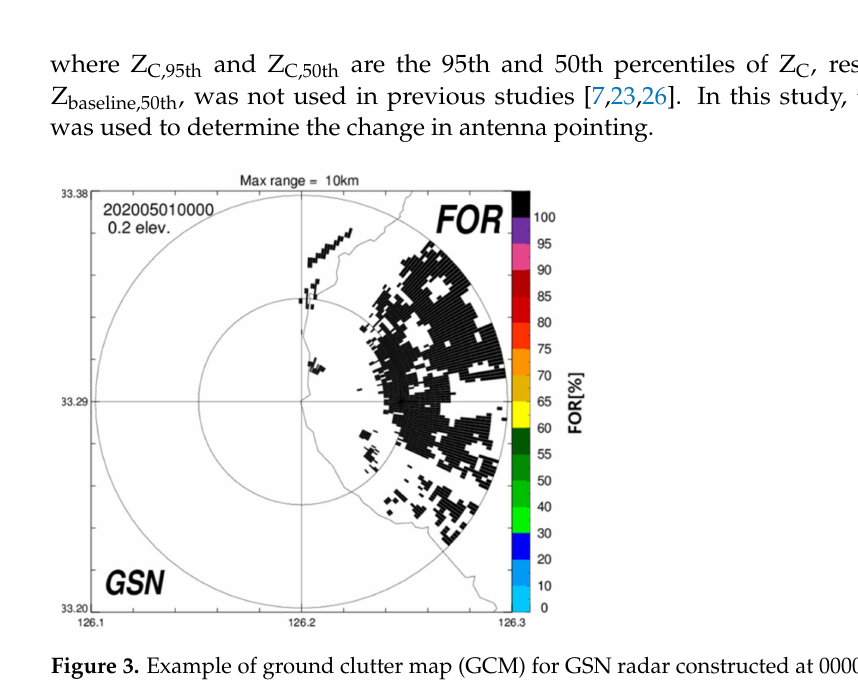
Figure 3. Example of ground clutter map (GCM) for GSN radar constructed at 0000 KST 1 May 2020. To estimate the calibration bias from RCA, the change in RCA ( ∆ RCA, Equation (3)) was defined as the difference between the most recent RCA (RCA recent ) and RCA at the current time (RCA current ). The calibration bias ( (cid:15) GC ) was estimated using the following